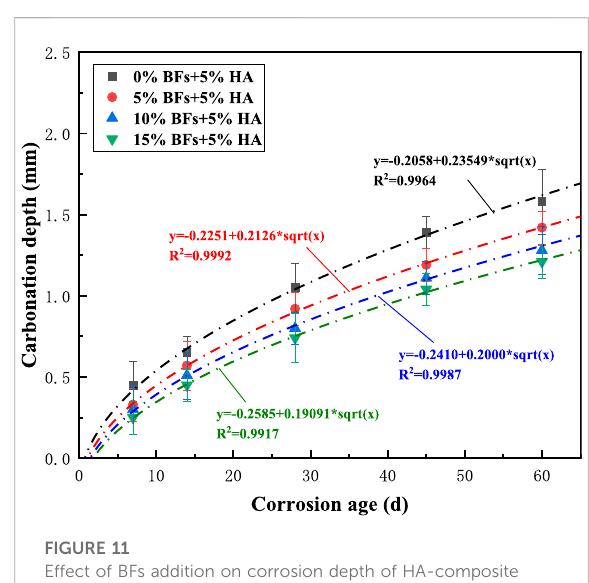
FIGURE 10 Thickening performance of multicomponent composite anti-corrosion cement slurry system.